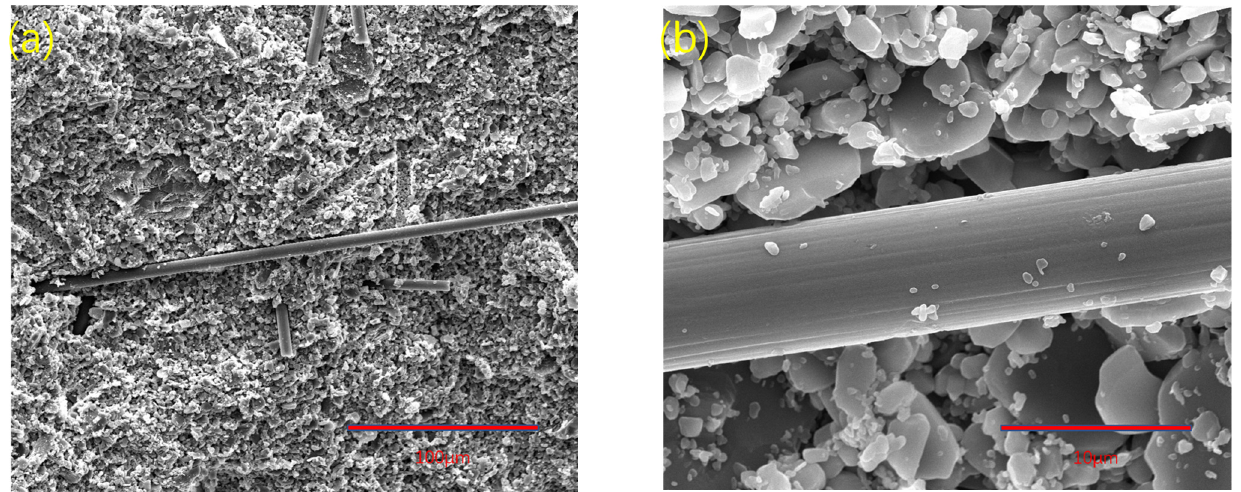
Figure 7. The 3D-printed SEM images of fracture of group B samples of alumina composite ceramics: ( a ) with 500× magnification and a scale of 100 μ m, the matrix and fiber were evenly distributed; ( b ) with 5000× magnification and a scale of 10 μ m, the interface between matrix and fiber was well bonded.